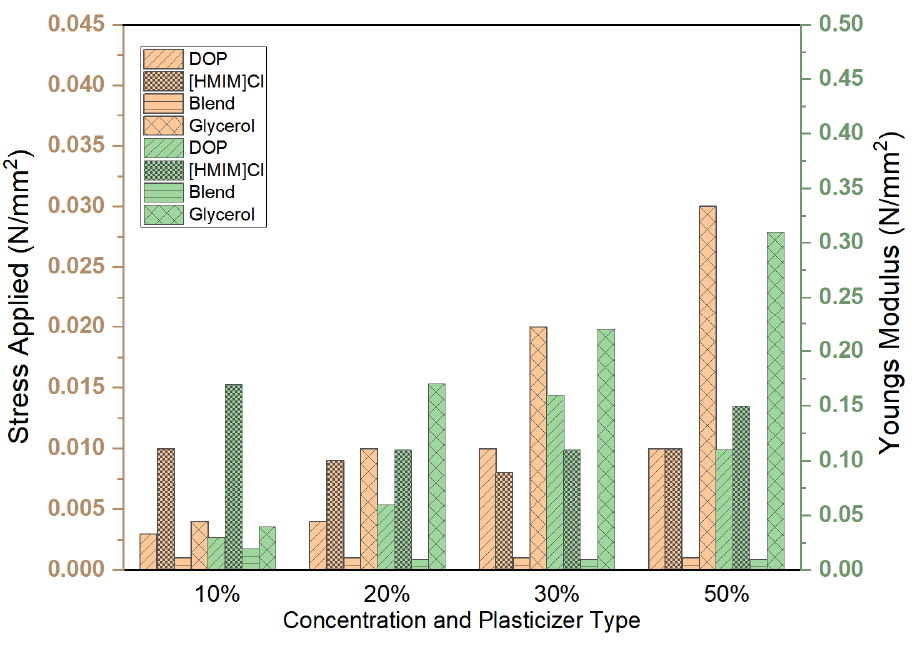
Figure 8. Effect of plasticizer type and concentration 10, 20, 30 and 50% on the endured stresses and strains as a ramp-displacement-type stress test was conducted. The resultant Young’s modulus has been calculated. For all samples, the strain endured was 0.1.